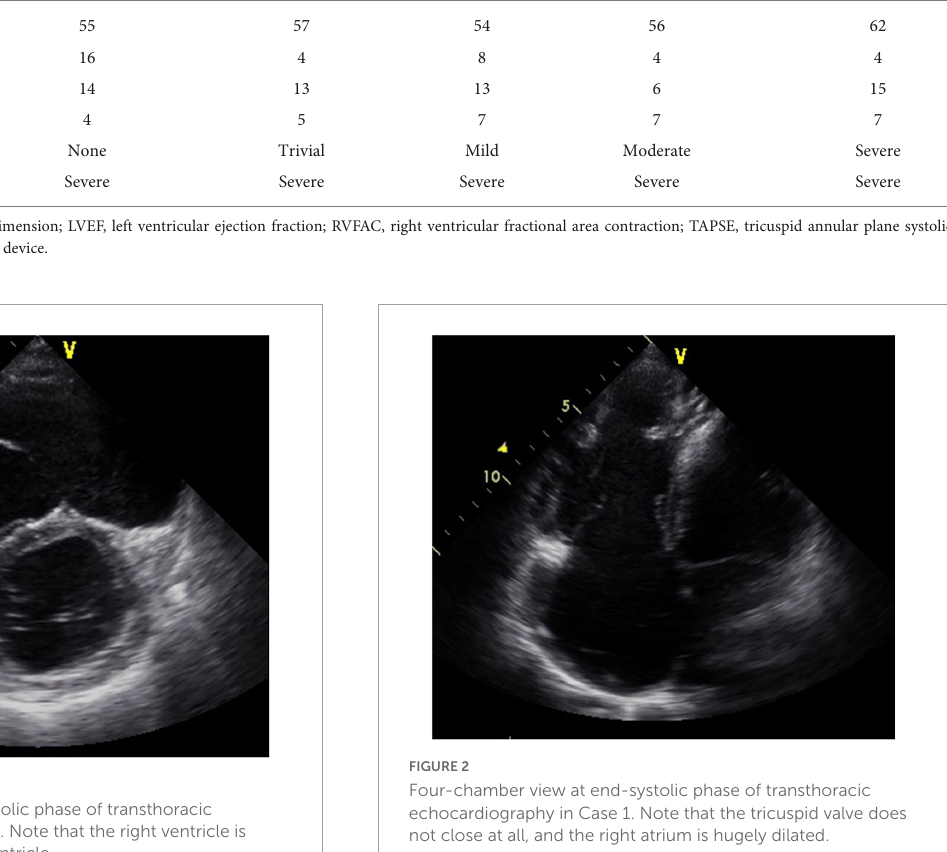
( Table 6 , Figures 5 , 6 , and Supplementary Movies 1, 2 ).